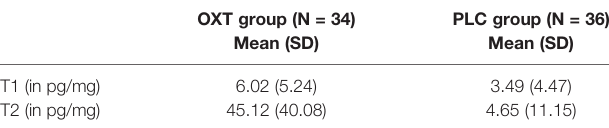
TABLE 2 | Measures of salivary OXT-levels.